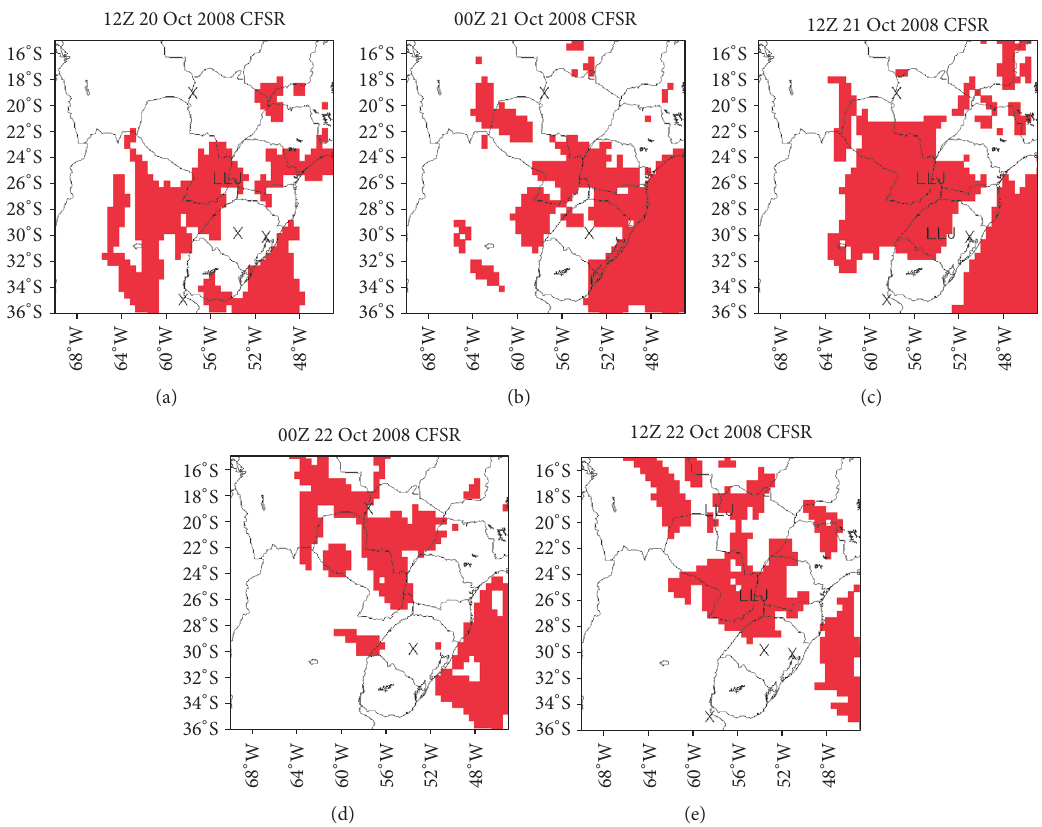
Figure 15: Time evolution of the spatial distribution of grid points from the NCEP-CFS Reanalysis data where a LLJS was identified over the La Plata Basin from (a) 12Z 20 October 2008 to (e) 12Z 22 October 2008 in 12hr intervals. Red areas indicate the identification of a LLJS with the NCEP-CFSR data, while the label “LLJ” [“X”] indicates an upper air meteorological station, where a LLJS was [was not]